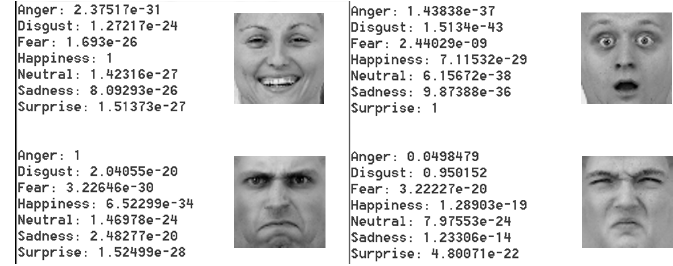
Figure 26. Four sample emotion images and the output given by the